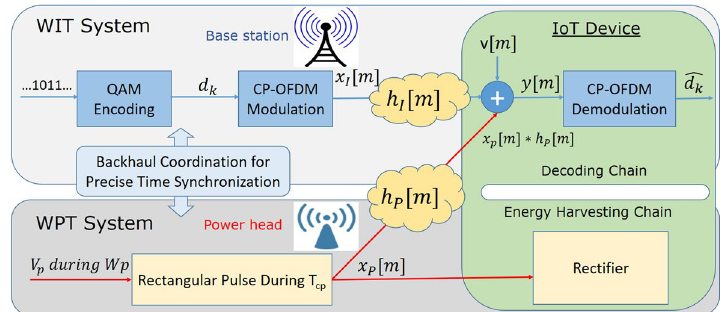
m due to the channel [ ]